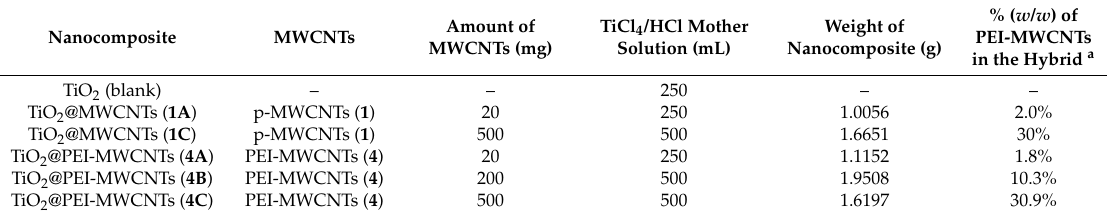
Table 1. Preparation of nanocomposites 1A , 1C and 4A - C